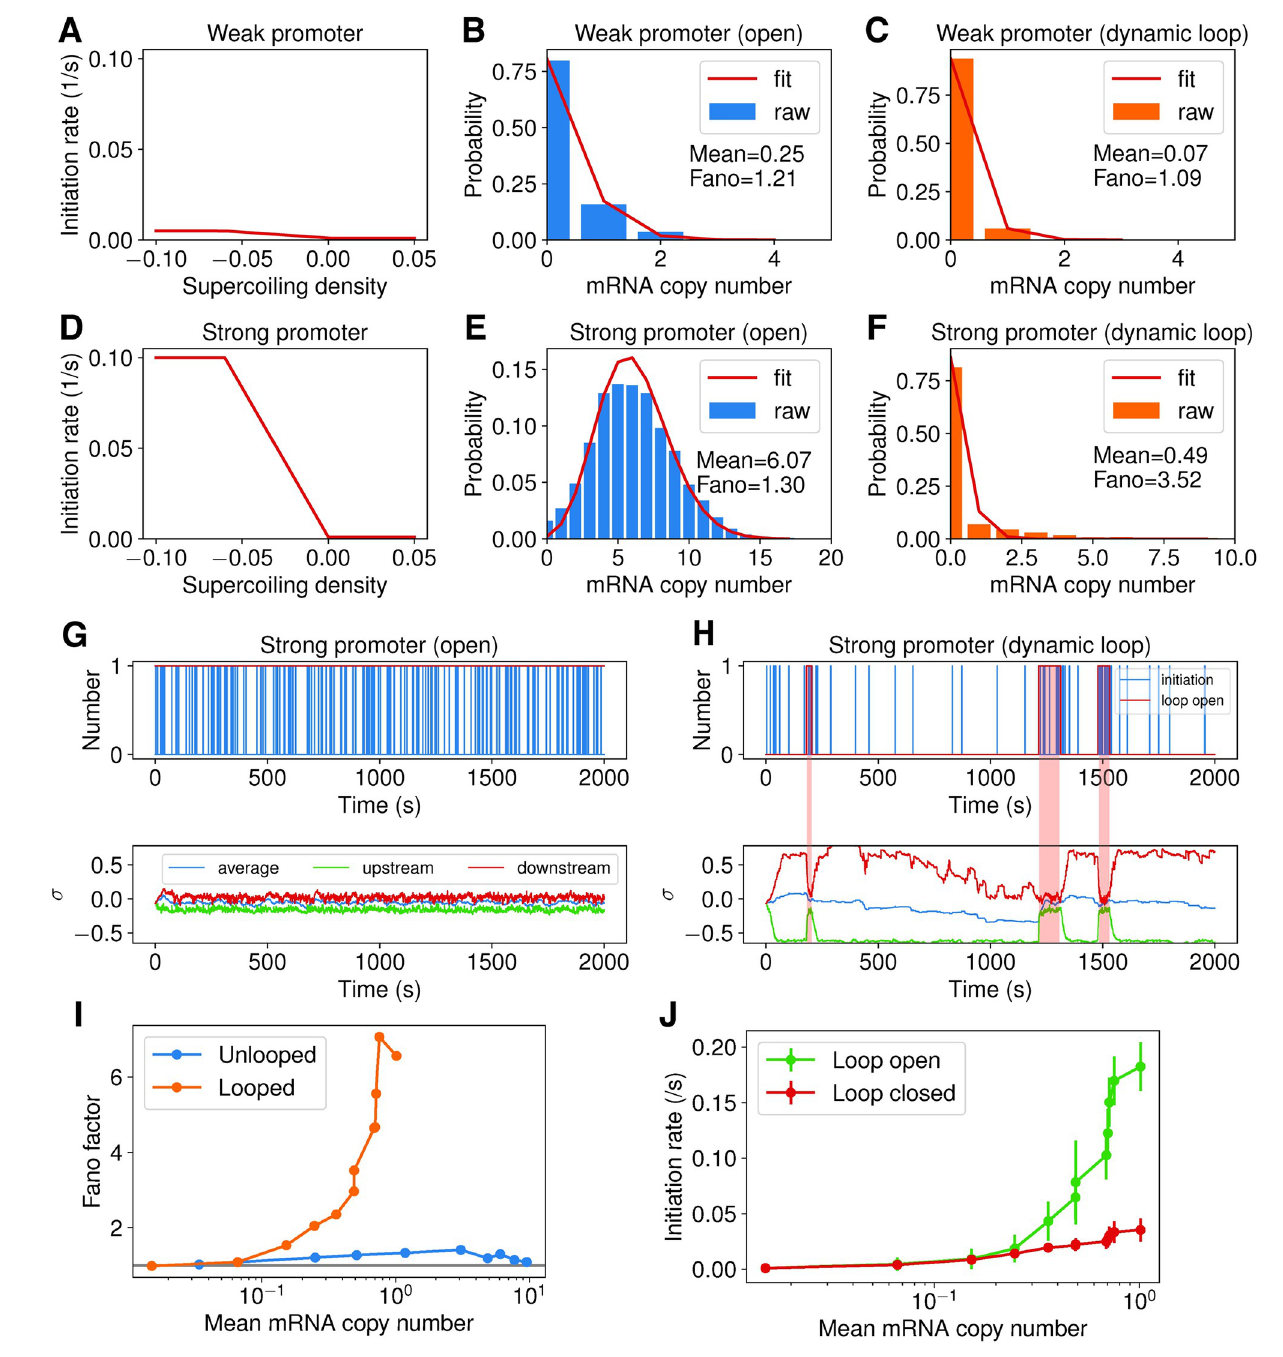
Fig 4. Dynamic topological domain formation results in bursty and noisy transcription from strong promoters through the accumulation and release of supercoiling. (A-F) Comparison of a weak promoter ( k = 0.005 s − 1 , top panel) and a strong promoter ( k = 0.1 s − 1 , bottom panel) in their responses to max max supercoil density (A and D), mRNA copy number distribution when the DNA is open (unlooped, B and E) and when the DNA dynamically loops and unloops (C and F). (G-H) Exemplary mRNA production time traces (top panel) and the corresponding supercoil density of the DNA (bottom panel) for the strong promoter in the open-DNA condition (G) and the dynamically looping condition (H). The pink-shaded regions in H indicate the time when the loop is open. (I) Comparison of the Fano factor as a function of mean mRNA copy number for genes in an open DNA (blue) and that in a dynamically looping DNA condition (orange). The grey line denotes Fano factor = 1. (J) Comparison of the average initiation rate of genes when the DNA is open (green) and when the DNA is closed (red) in the dynamically looping DNA condition.